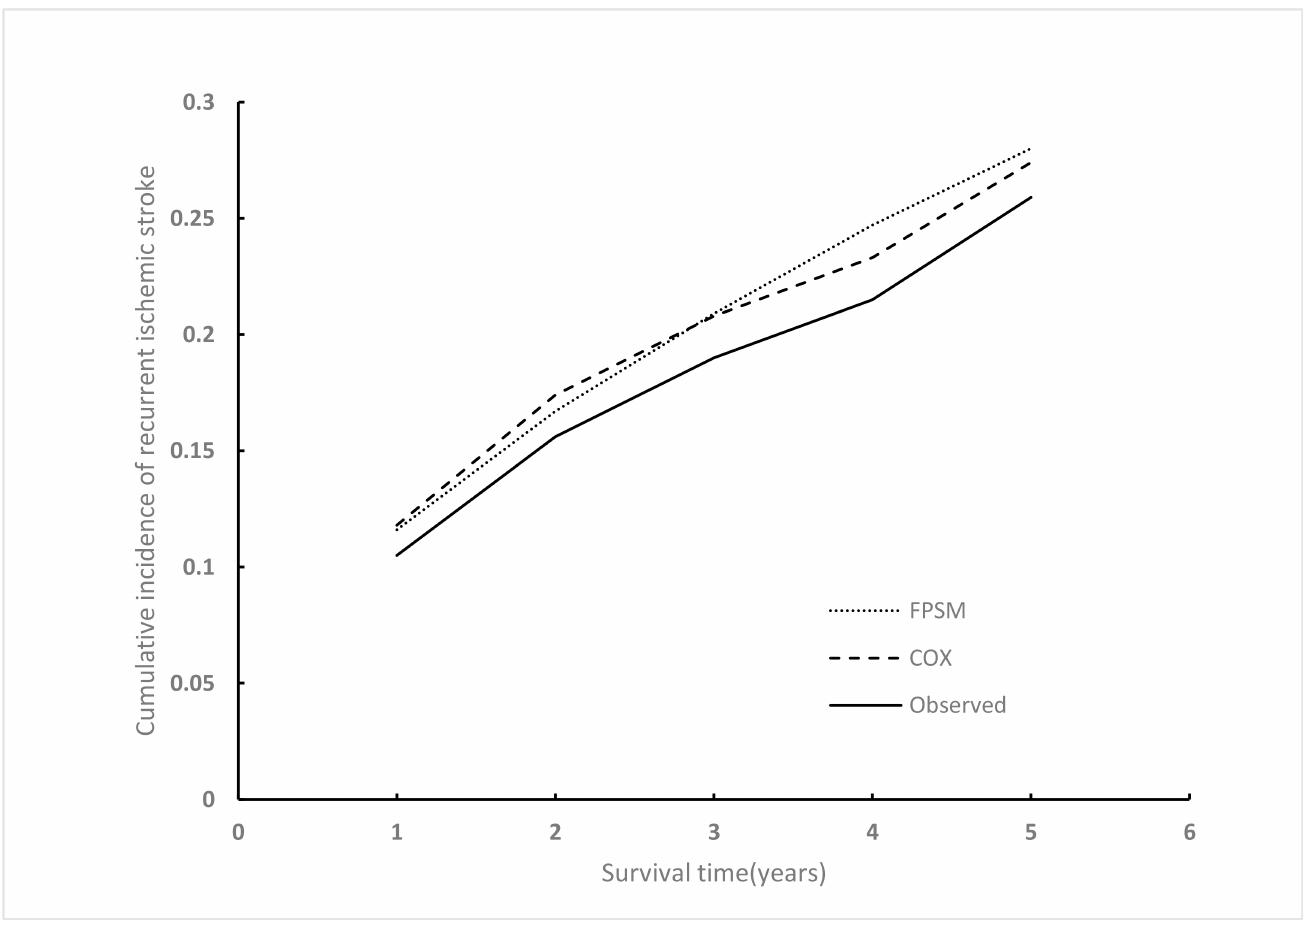
Fig 3. Cumulative incidence of recurrent ischemic stroke over 5 years of follow-up. https://doi.org/10.1371/journal.pone.0200807.g003 cost. Compared with aspirin, patients receiving clopidogrel had higher medical costs, but the QALYs gained were higher, while the patients without antiplatelet therapy had higher medical costs and lower QALYs. The incremental cost-effectiveness ratio (ICER) of clopidogrel to ASA Table 4. Incremental Cost-effectiveness